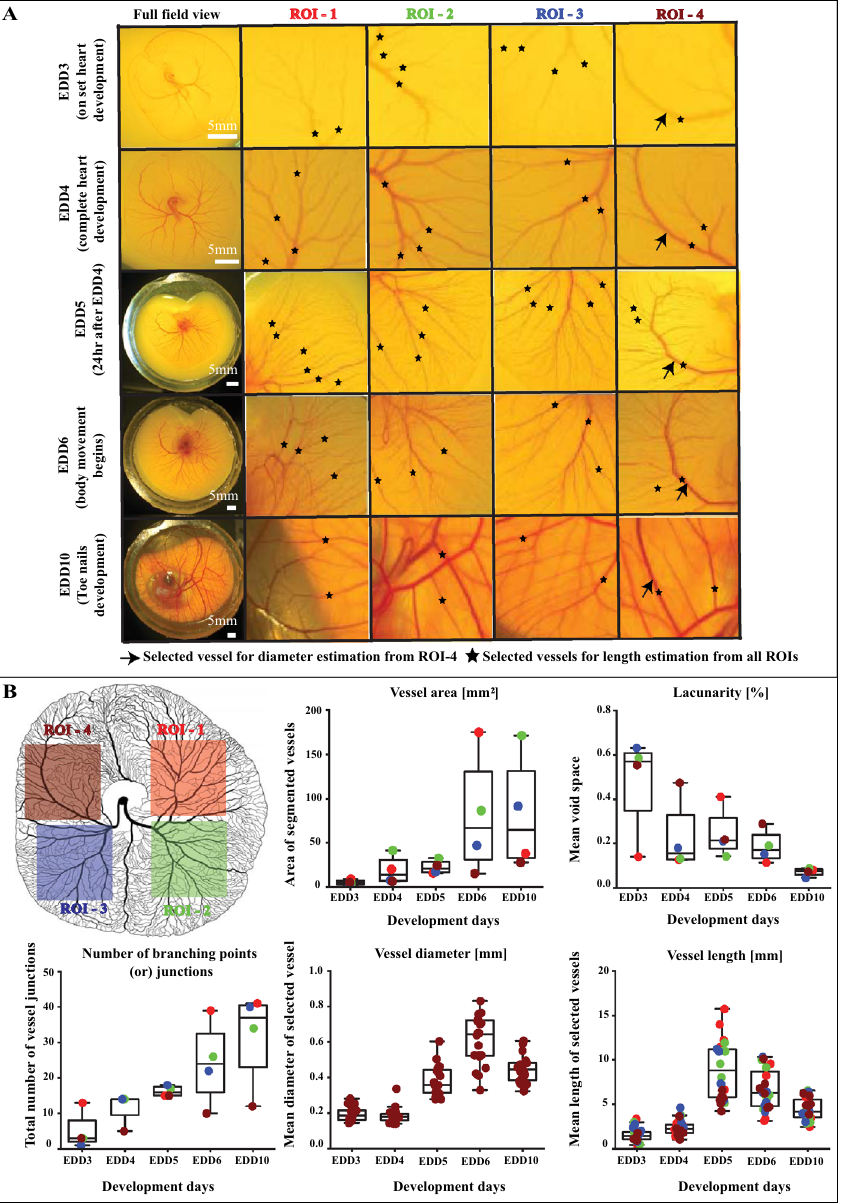
Figure 2. Organization of developing vascular networks. Panel ( A ) shows the snapshots of entire vascular networks of developing chick embryo including the CAM cultured within artificial eggshell culture system. The figures represent the developmental stages of day 3–6 and day 10, displaying the evolution of vascular network organization in both space and time. For videos, see Supplementary Video S6. Panel ( B ) represents the schematic figure of chick vascular network of the CAM development day 5 with highlighted ROIs, which are used for reference in Panel ( A ) and for the quantitative analysis. These multiple ROIs can be used for performing statistical analysis. Measured values are calculated from one sample ( n = 1) and represented as mean ± SD along with individual data points. Measured values are compared within 4 different ROIs for different development days as indicated. Vessel diameter are calculated from single vessel of ROI-4 for different development days (highlighted with black arrows) and vessel length are calculated from multiple vessels from all ROIs (highlighted with black asterisks). For detailed explanation about quantitative analysis, see methods section and Supplementary Figure S2. Schematic figure in Panel ( B ) was created using Adobe